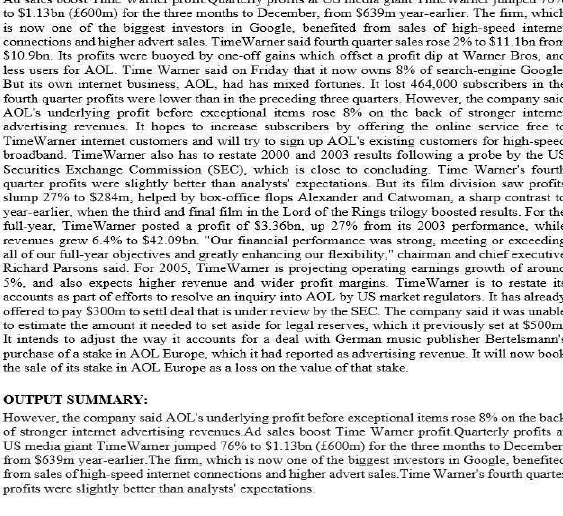
Fig. 3. Output for text input